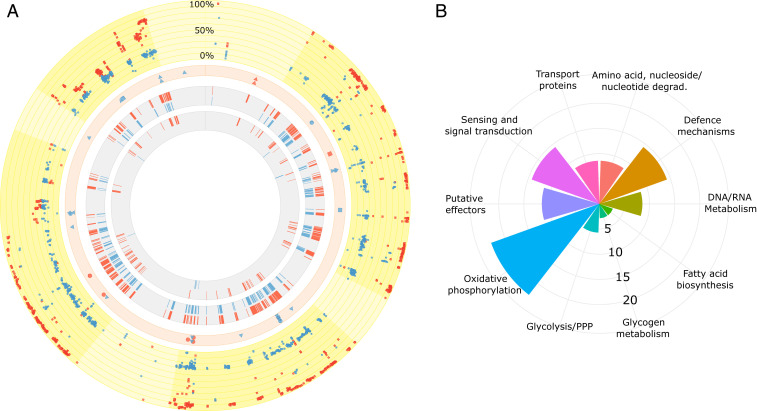
A majority of genetic variants strongly increased in frequency in the symbionts from the HT regime and were associated with differentially expressed genes. The circular plots represent the symbiont genome. (A) In all four rings, red indicates HT and blue indicates VT. The outermost ring depicts a scatterplot for the entire symbiont genome with all of the 1,436 ancestral genetic variants identified in the HT and VT symbiont populations. A large majority of the HT variants reach very high frequencies above 80%. One symbol represents a single variant. Lighter yellow sections represent conserved regions of the genome that possess a high proportion of housekeeping genes and are less affected by variants (i.e., genes involved in replication, translation, central carbon metabolism, energy production and conversion, metabolism, and transport). The second ring shows the location of the 33 novel variants (9 = HT; 24 = VT) identified throughout the genome (circle, intergenic; triangle, genic; and rectangle, potential promoter region). The third ring depicts those genes from either treatment (354 = HT; 248 = VT) that 1) harbored variants with a pronounced difference in frequency (±15%) between the two treatments, and 2) were differentially expressed in the respective treatment. The innermost ring depicts those genes (112 = HT; 8 = VT) from the third ring that were solely differentially expressed in one but not the other treatment. Genome visualization was carried out with Circos (32). (B) Coxcomb chart summarizes the known functional categories of the 112 unique genes differentially expressed in the HT symbiont population. Axis indicates the percentage of genes affected per functional category. All individual values are provided in Dataset S3.